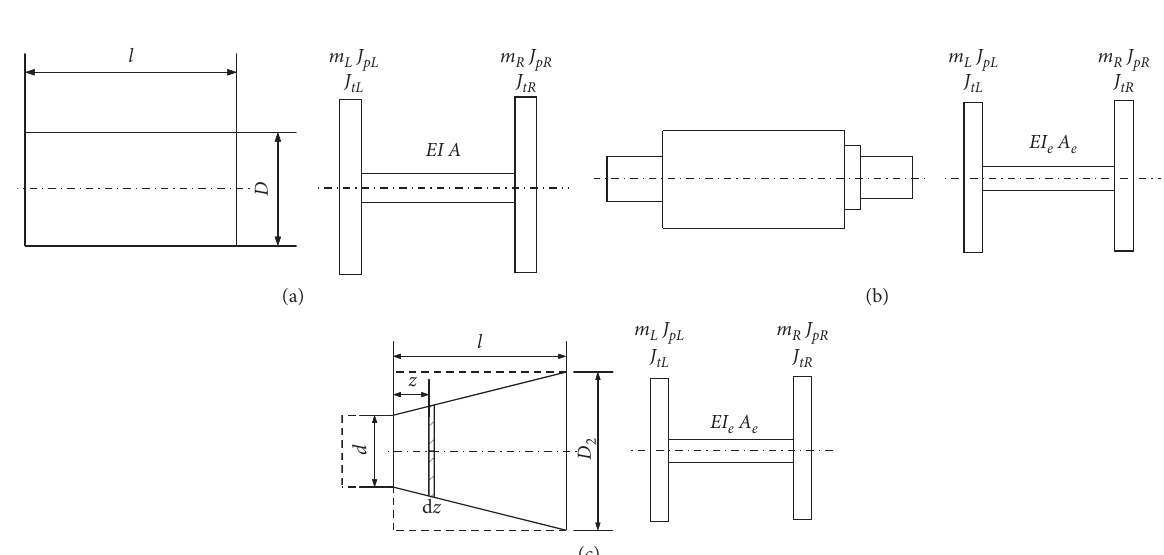
of the stepped shaft [17]. z